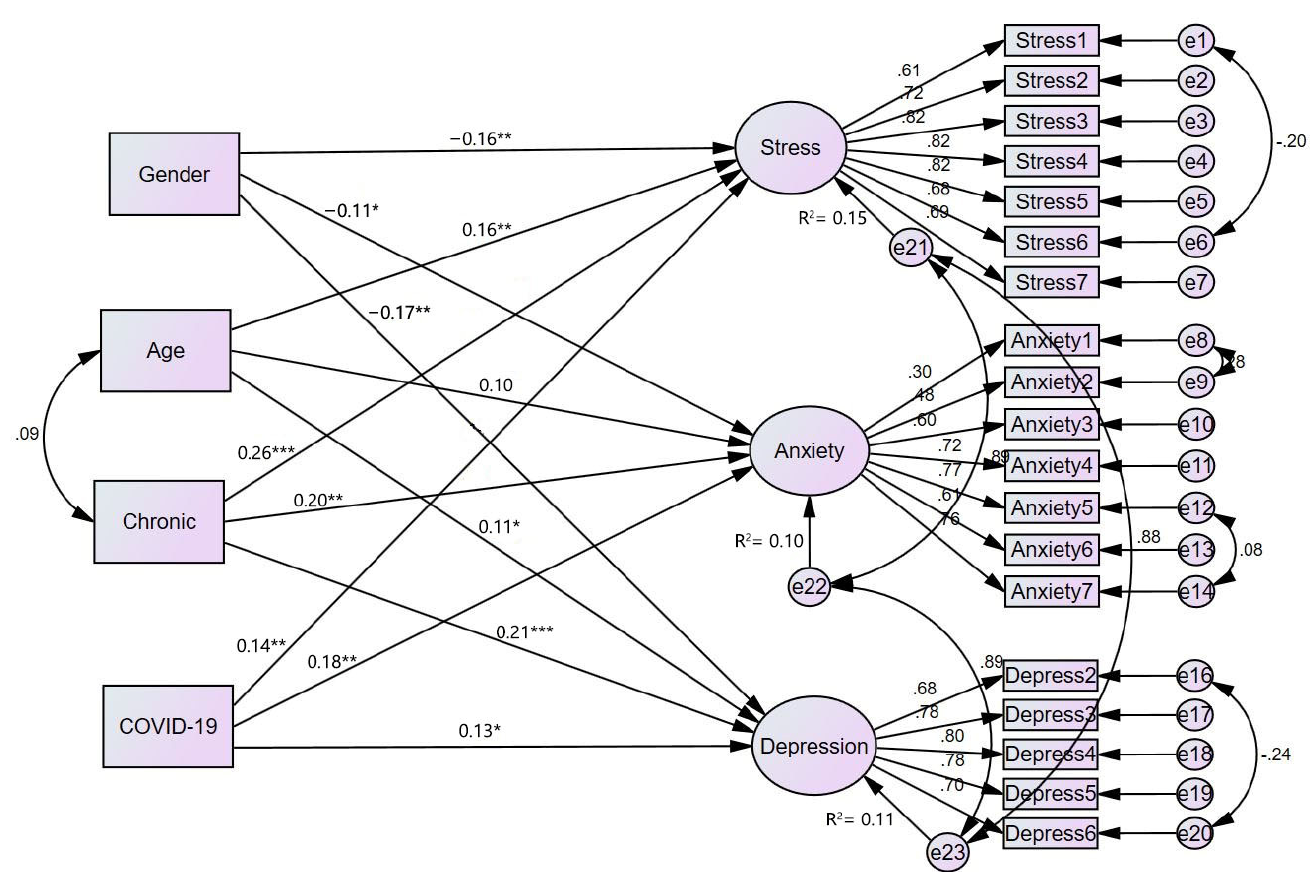
Figure 2. Structural model examining students’ demographics effect on DASS-21. Note: Chronic = chronic health conditions, COVID-19 = relative with COVID-19. * p < 0.05, ** p < 0.01, *** p < 0.001.